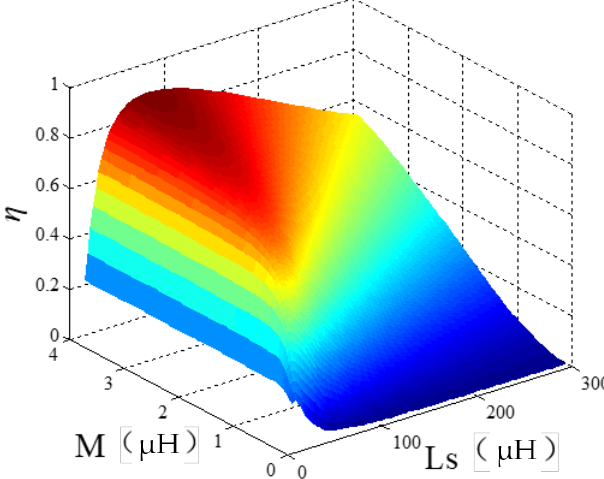
Figure 4. Output efficiency with M and L S . μH